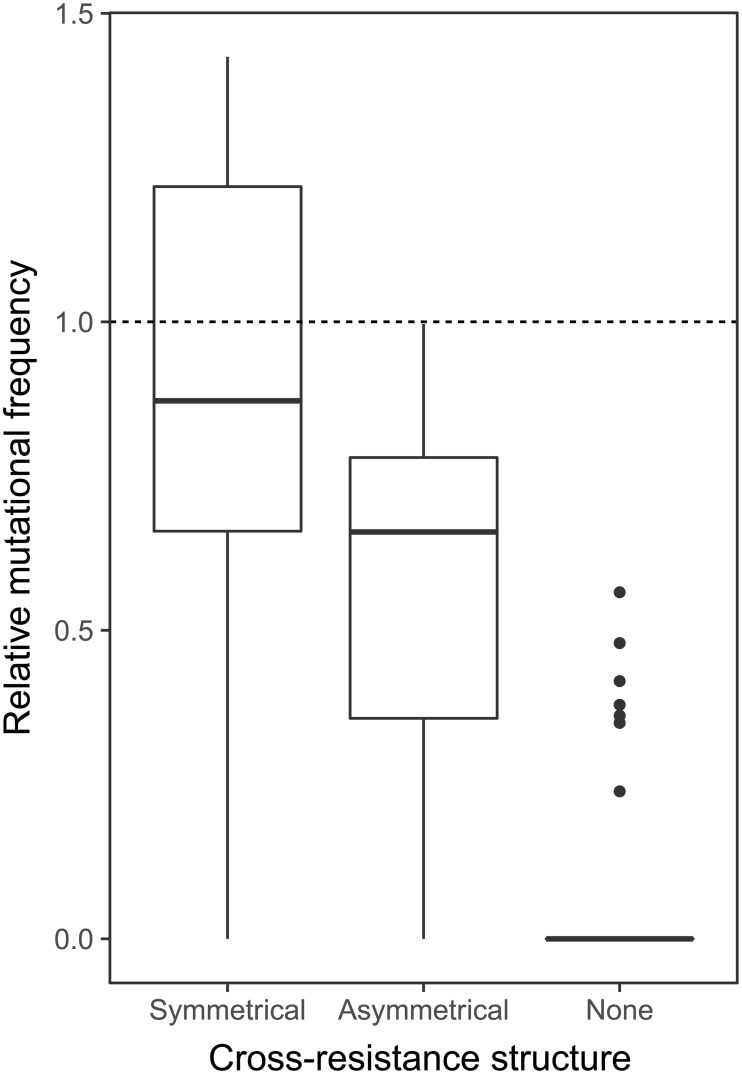
Relative mutational frequency for resistance against phage pairs exerting symmetrical, asymmetrical, or no cross-resistance.Relative mutational frequency compares the frequency of resistance mutations against phage pairs to the geometric mean of mutational frequency against each individual phage. Dashed line represents equal frequency of resistance mutations against a phage pair versus the constituent phages individually. Raw data are provided in S5 Data.